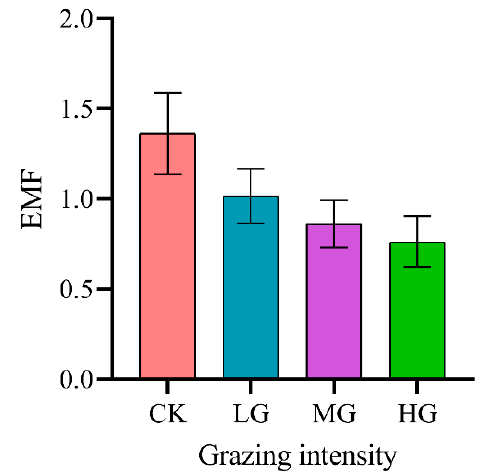
Figure 3. The effect of grazing intensity on ecosystem multifunctionality (EMF). Different lowercase letters show significant differences between means ( p < 0.05). The non-significant differences are not marked by any letters. CK, no grazing; LG, light grazing; MG, moderate grazing; HG, heavy grazing.